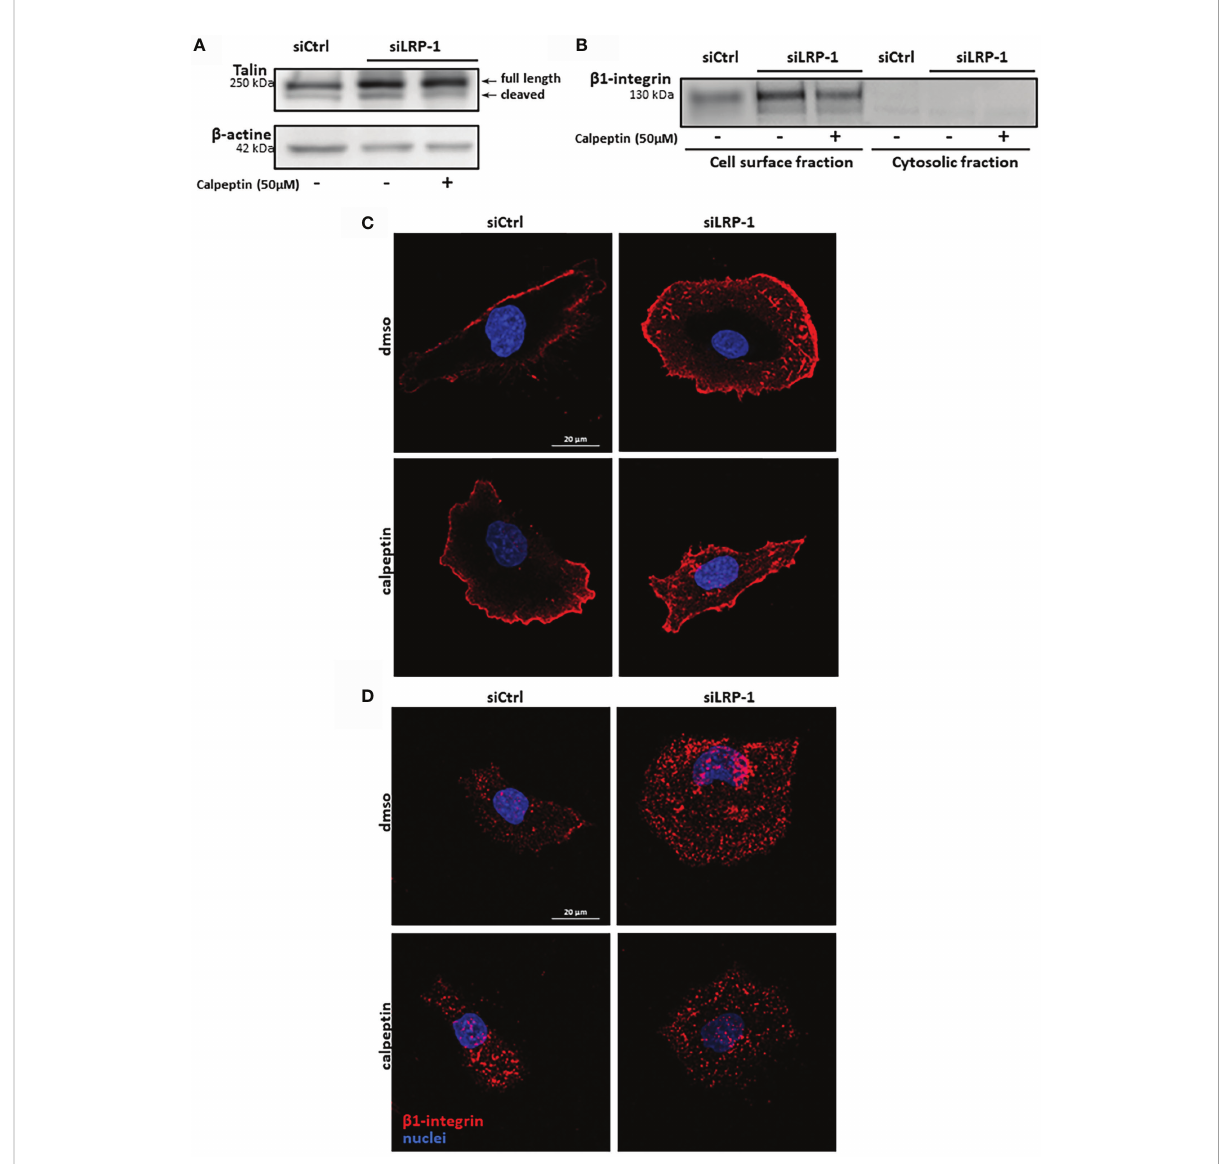
FIGURE 7 b 1 integrin membrane expression is controlled by LRP-1-dependent calpains regulation. Whole extracts from FTC133 cells transfected with siRNA sequences, seeded onto gelatin and cultivated in the presence or absence of calpeptin for 3 hours were analyzed by SDS-PAGE and western blot using speci fi c 8D4 antibodies against talin, allowing the detection of native full length and calpain-released cleaved product of talin. b -actin that was used